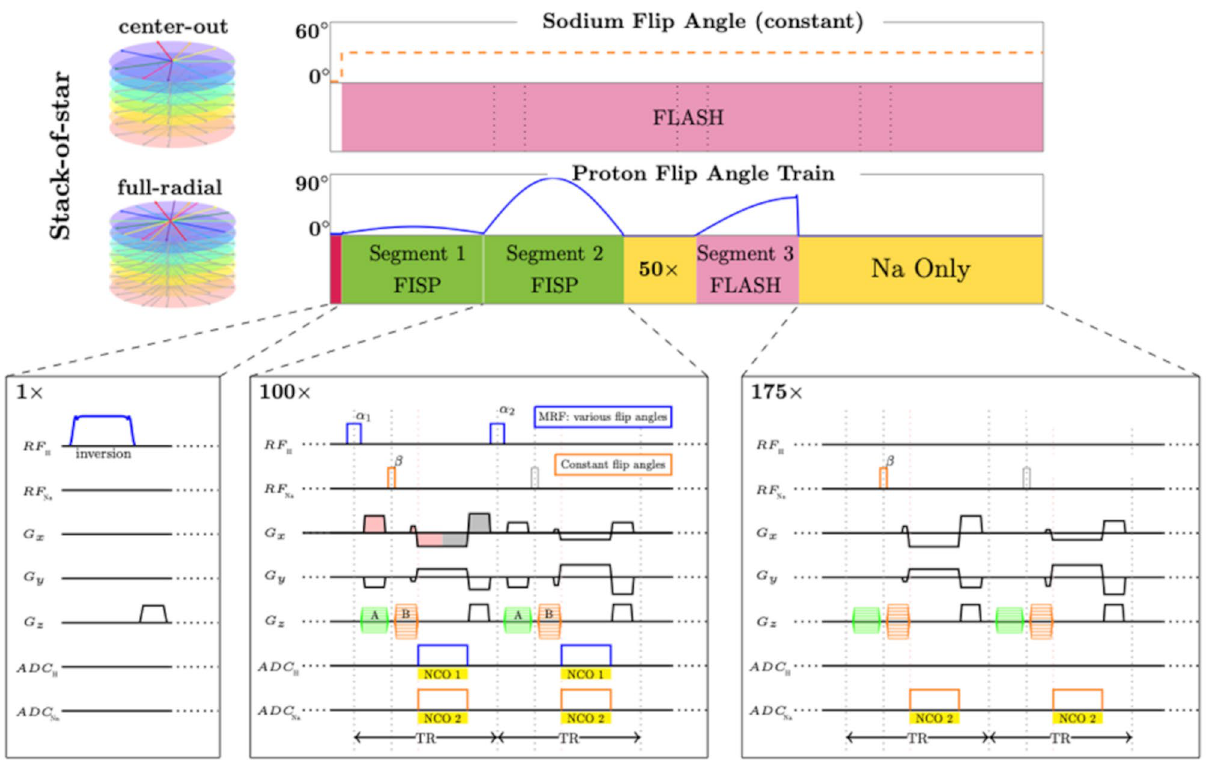
Figure 4. Diagram of the 3D simultaneous 1 H MRF/ 23 Na MRI sequence, reprinted with permission from Yu et al . 22 . The diagram on top shows the sodium excitations with constant flip angle and the proton MRF pulse train with variable flip angles. The details of the sequence for different segments are shown in the corresponding boxes on the trajectory for 1 H and a center-out radial trajectory for 23 Na were obtained in k-space, leading to a ratio of ~ 1.9 in in-plane resolution between the 1 H and 23 Na images. The full radial trajectory was chosen to minimize the effects of B 0 inhomogeneities in 1 H 22 . The SAR calculation contemplates both nucleus irradiations. More details about the simultaneous 3D 1 H MRF/ 23 Na MRI sequence can be found in Yu et al . 22 . A diagram of the sequence is shown in Fig. 4. The 3D simultaneous 1 H MRF/ 23 Na MRI sequence parameters were: FOV 240 × 240 × 168 mm 3 , 1 H 160 × 160/ 23 Na 84 × 84 matrix, 1 H 1.5 × 1.5 mm 2 / 23 Na 2.85 × 2.85 mm 2 in-plane resolution, 1 H TR = 7.5 ms/ 23 Na TR = 15 ms, 1 H TE = 2 ms/ 23 Na TE = 1 ms, 1 slab of 56 slices, 3 mm slice thickness for both 1 H and 23 Na, 6 shots per slab, total scan time 21 min.